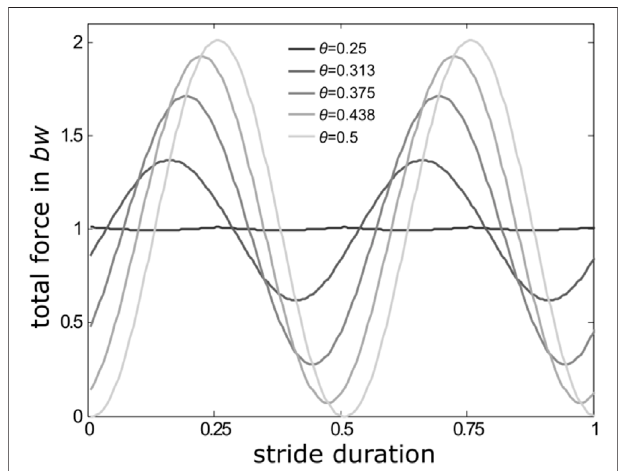
FIGURE 1 | Reduction of total force amplitudes with changing ipsilateral phase relations in a quadrupedal locomotor system moving with stance and swingdurationsofequallength,i.e.withadutyfactorof0.5.At θ (cid:1) 0.5(lightgrey force trace), i.e. alternating sets oflegs (trot), the consecutive sine-shaped GRF-traces coincidewiththestancephasesofthetwo successivelyactivesets of legs. The more θ deviates from 0.5, single leg GRFs increasingly blend into each other and total force amplitudes decline to reach a minimum with only minor oscillations around body weight ( bw ) at θ (cid:1) 0.25 (dark grey